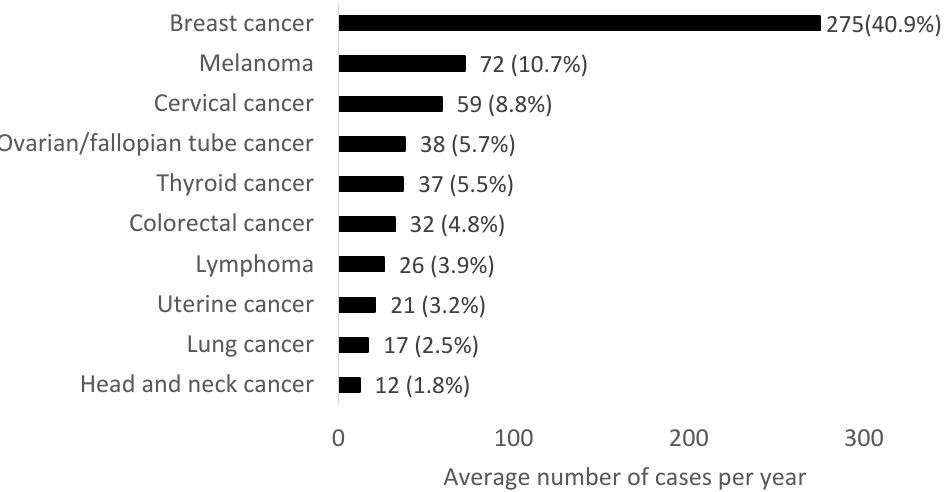
Figure 3. Average number of cases per year for the most common cancers (excluding non-melanoma